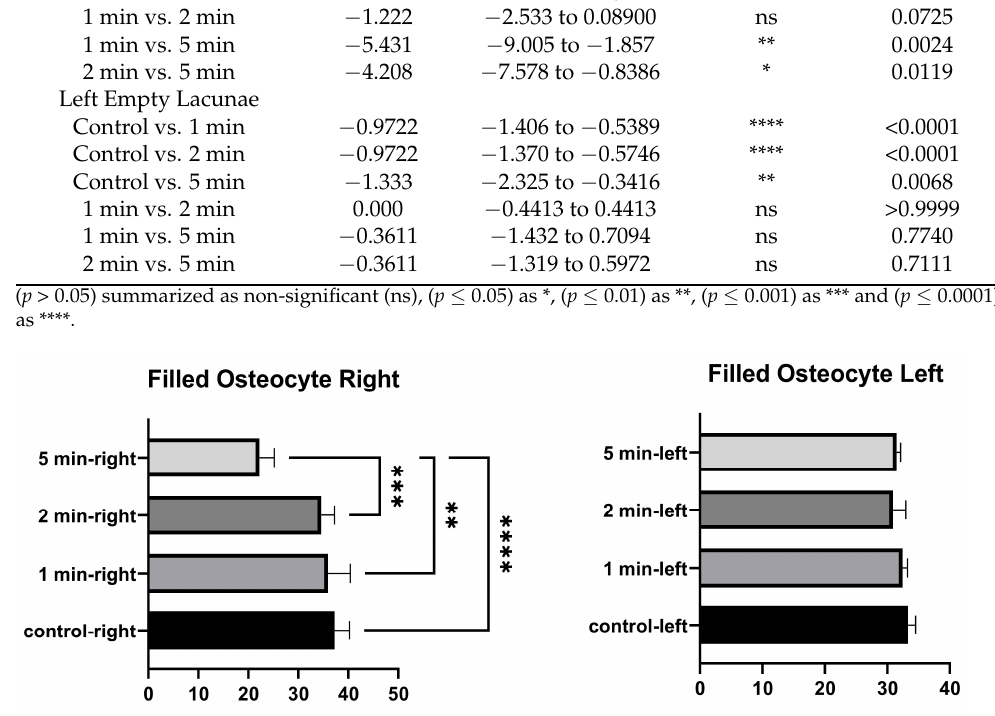
Figure 5. Filled osteocytes graphs of the left and right tibia. ( p ≤ 0.01) as **, ( p ≤ 0.001) as *** and ( p ≤ 0.0001) as ****. Table 3. Filled osteocytes table of the left and right tibia.